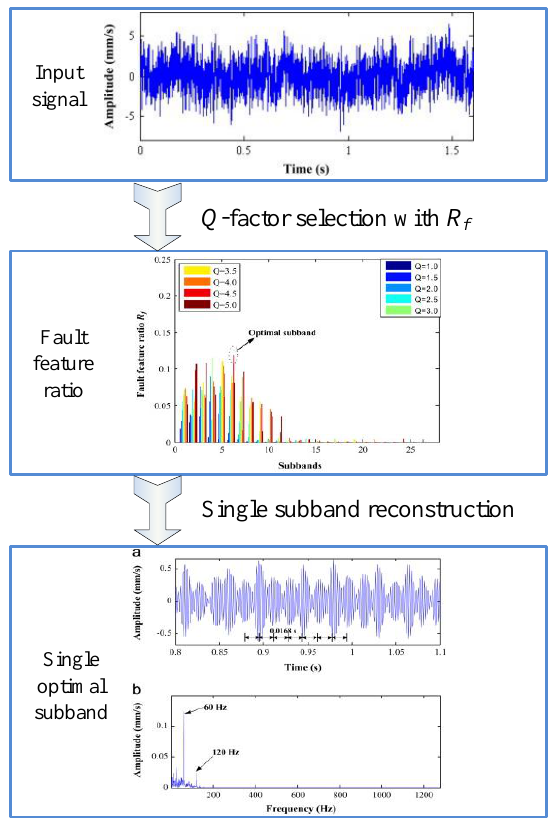
Figure 16. Example of bearing fault diagnosis via ensemble super-wavelet transformation (ESW) [63].